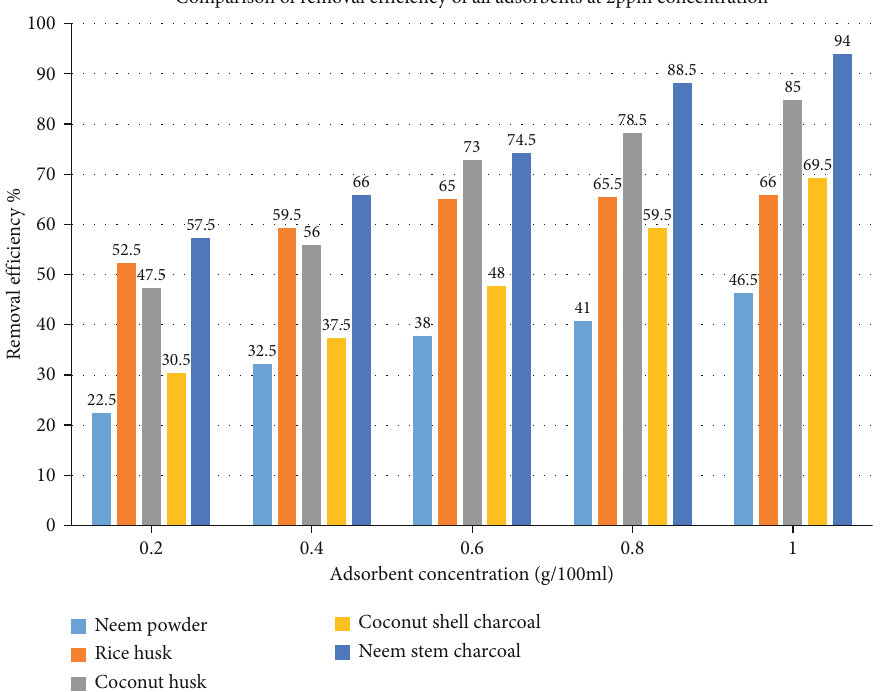
Figure 7: Comparison of removal e ffi ciency of all adsorbents at 2 ppm.